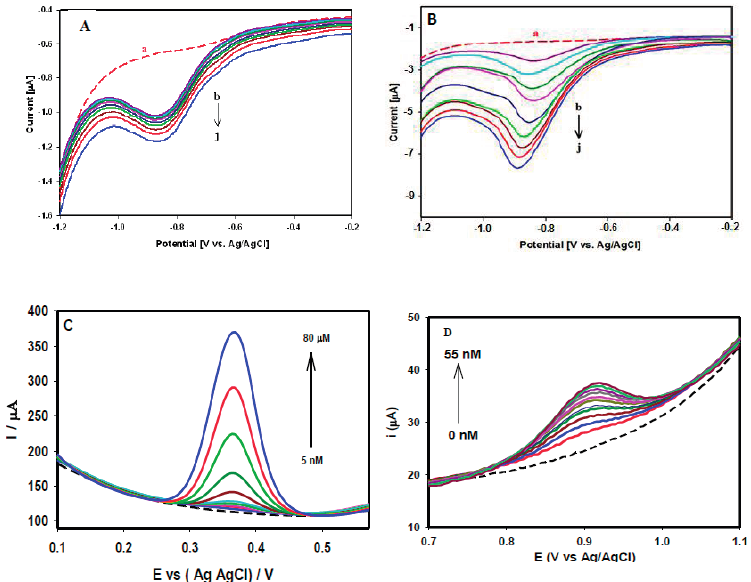
Figure 2. Responses of the SWCNTs/GCE recorded in 0.1 M PBS (pH 7.4) ( A ) and ( B ) SWV responses of different methylglyoxal concentrations (0.1 µM to 100 µM) ( C ) DPV responses of acetaminophen (5 nM to 80 µM) and ( D ) DPV responses of valacyclovir (5–55 nM). Figure 2A,B reproduced with permission from [18]. Copyright 2013 Elsevier. Figure 2D reproduced with permission from [19]. Copyright 2013 Royal Society of